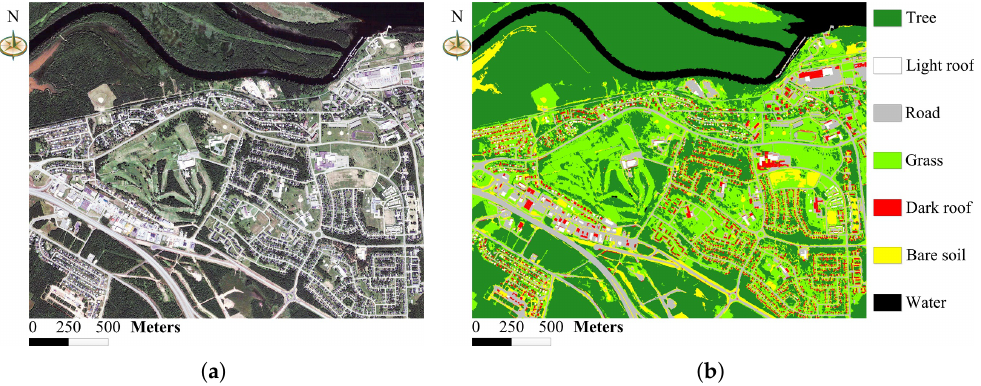
Figure 6. The selected test image and corresponding reference map: ( a ) high spatial resolution test image; and ( b ) reference